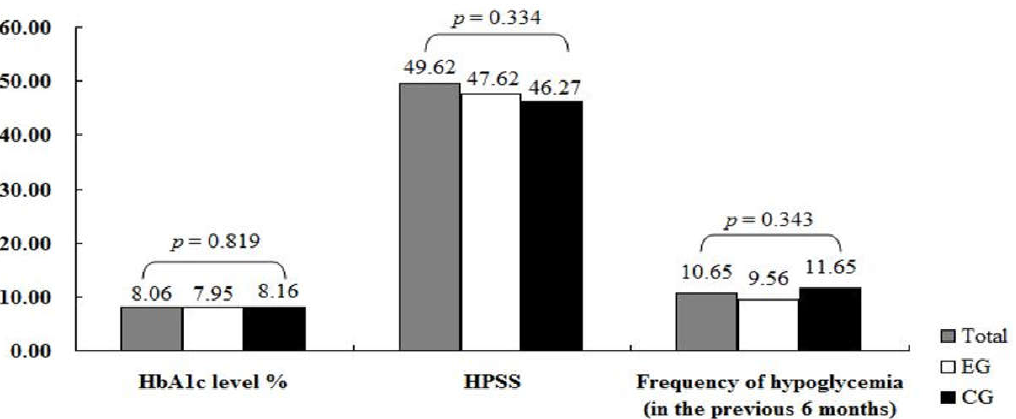
Figure 2. Comparison of group outcomes at baseline (N = 71): EG, experimental group ( n = 34); CG, control group ( n = 37); HPSS, Hypoglycemia Problem-Solving Scale.